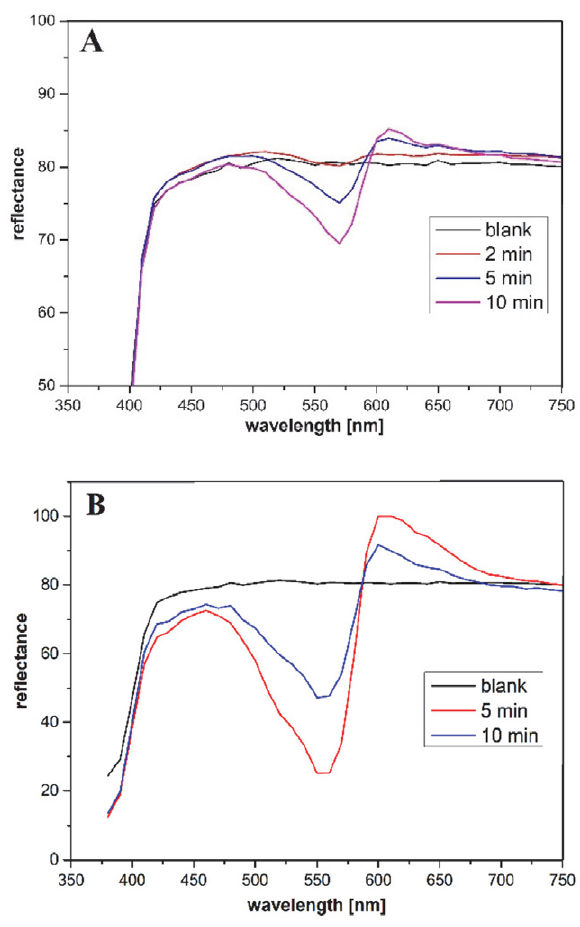
Figure 7: The colour reaction of the detection film depending on the exposure time concerning the most significant interfering sub- stances, for example (A) benzoyl chloride at the concentration of 2.8 mg/m 3 and (B) hydrogen chloride at the concentration of 5.8 mg/ m 3 , were measured.